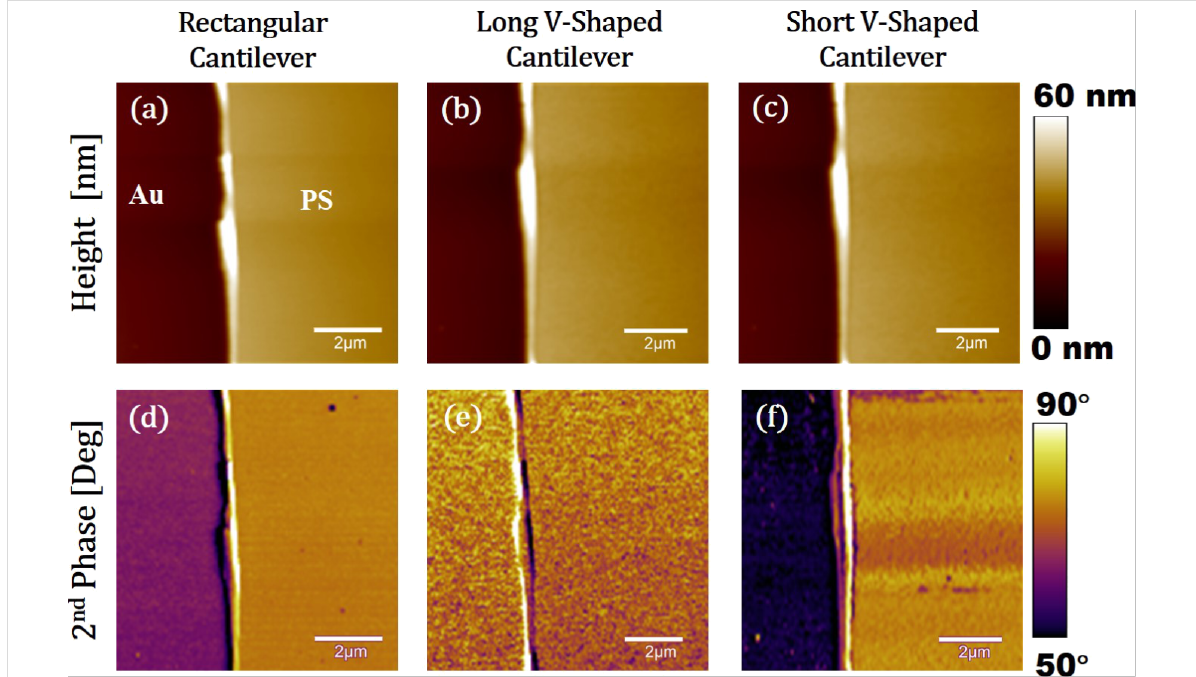
Figure 13: Bimodal AFM images of Au–PS samples. Left column: MULTI75G, middle column: TR400Long, right column: TR400Short. (a), (b), and (c) are height images. (d), (e), and (f) are phase images. All images were recorded at the same spot with a scan rate of 0.5 Hz, a setpoint ratio of 65%, a first eigenmode amplitude of A 1 = 10 nm, and A 2 = 2 nm. The gain was adjusted to maintain the quality of the images. The image size is 10 µm times 10 µm.